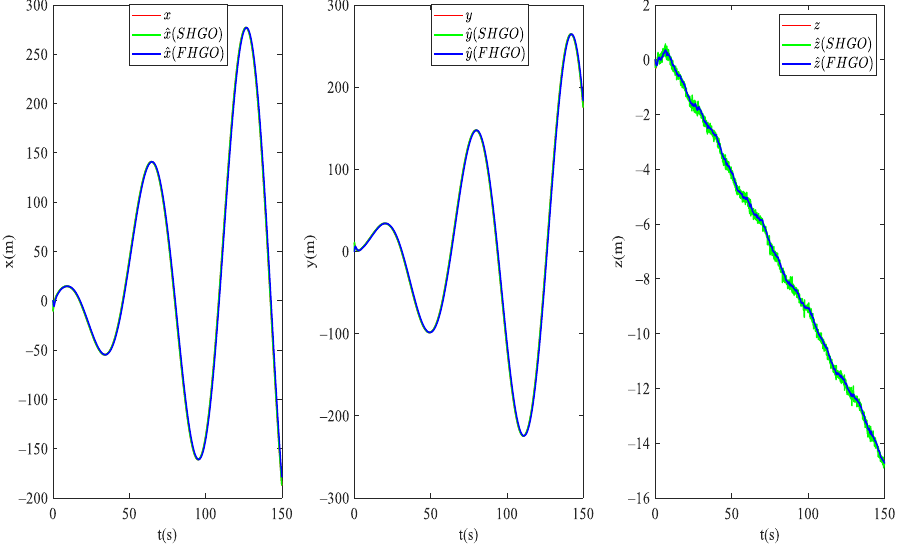
Figure 3. Position states estimation of state observer in x , y and z directions.